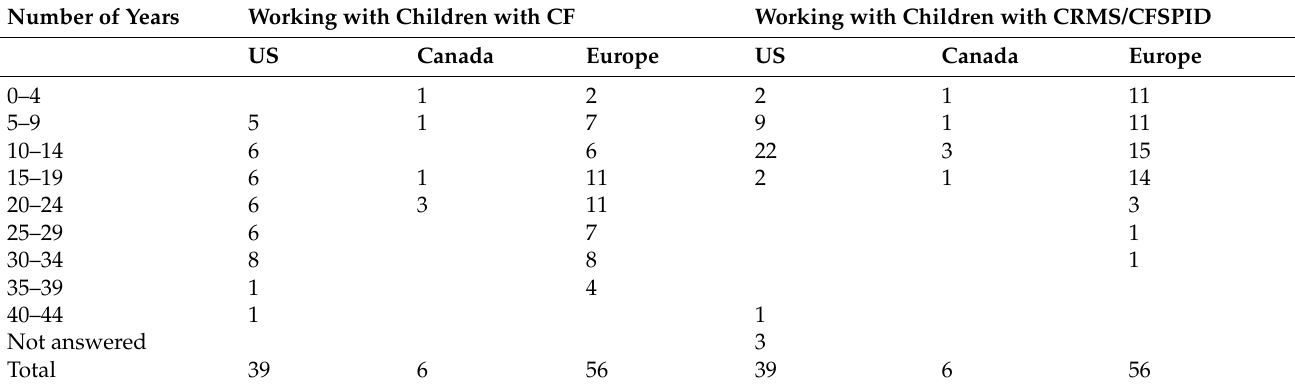
Table 2. Years working with children with CF and